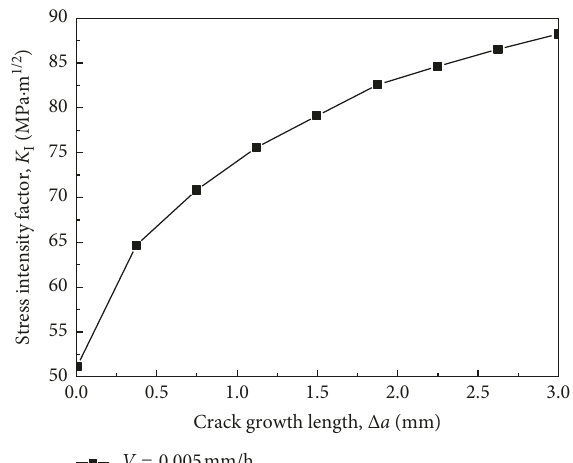
Figure 13: The relationship between stress intensity factor and crack growth rate.